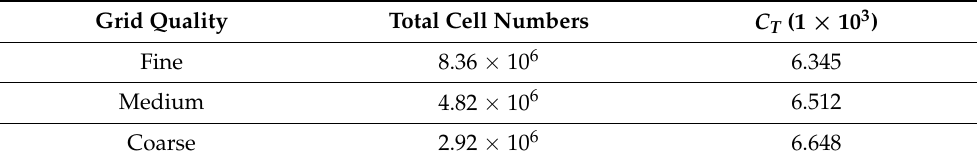
Table 3. Resistance values at Fr = 0.45 by different grid